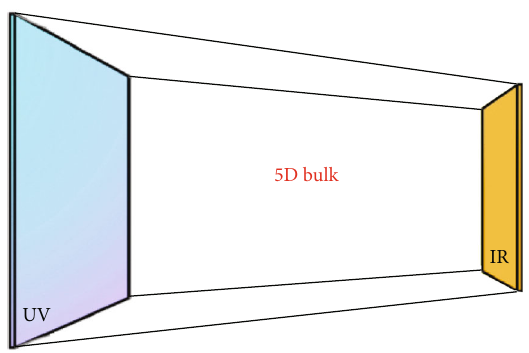
Figure 6: Schematic view of the Clockwork/Linear Dilaton model.